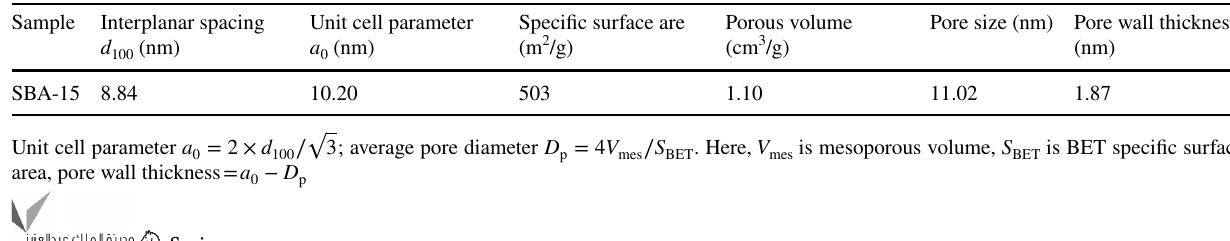
Table 1 Physicochemical properties of SBA-15 sample